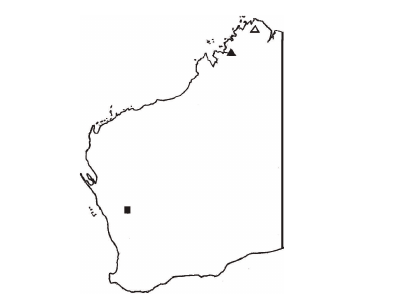
Figure 3: Known distributions in Western Australia. ( (cid:2) ) Litopous behri ; ( (cid:3) ) Scaphinion clavatus and S . sp. 1; ( (cid:4) ); Scaphinion sp.